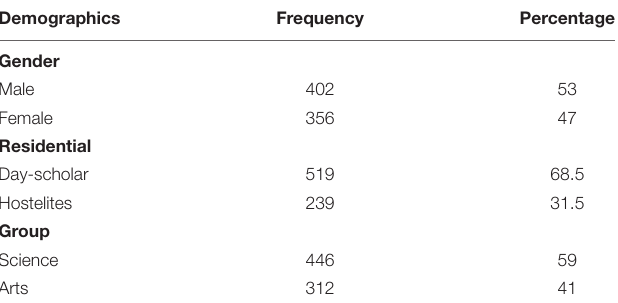
TABLE 3 | Demographics of study respondents.